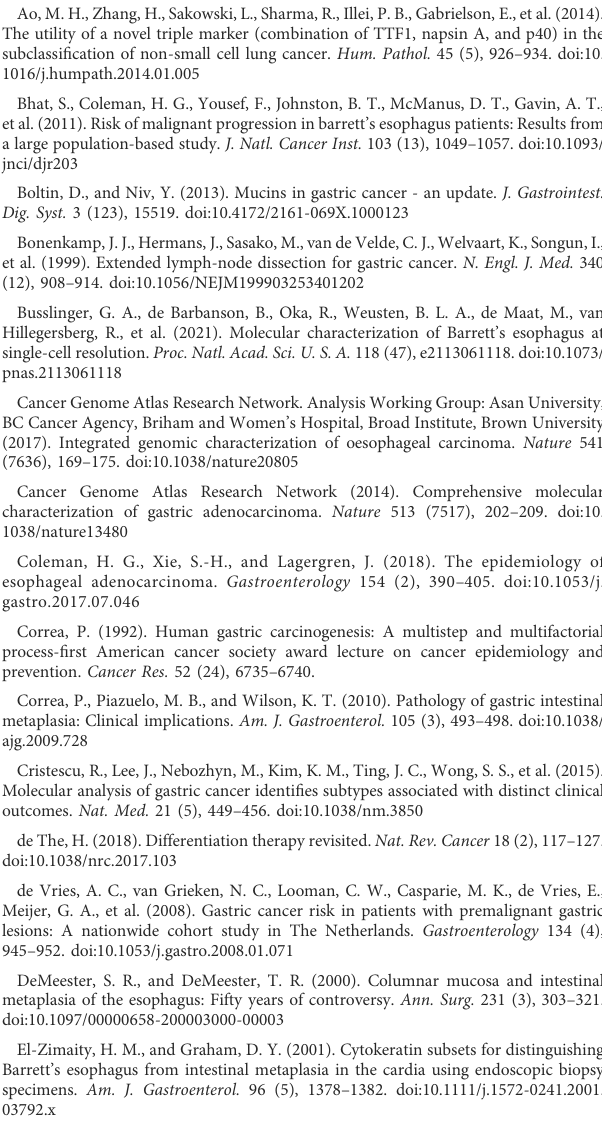
Barrett ’ sesophaguswithhigh-gradedysplasia,EAC:esophagealadenocarcinoma). SUPPLEMENTARY TABLE S2 The Fisher ’ s exact test p -values of IHC marker expression for gastric cases. P-values were calculated by testing for the difference in the mean IHC scores of the indicated markers. Fisher ’ s exact test was used. P < 0.05 is considered statistically signi fi cant. Comparisons were between normal and lesion phenotype groups, or 2 lesion phenotype groups (GIM: gastric intestinal metaplasia, GA: gastric